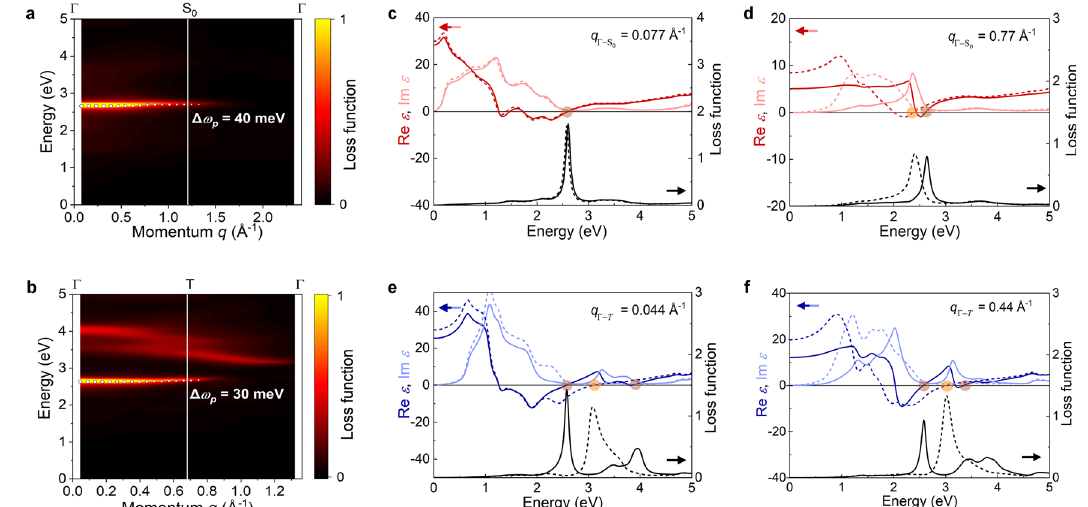
e , f Dielectric function (upper panel) and loss function (lower panel) of α -Ti 2 O 3 for q =0.044Å − 1 and q =0.44Å − 1 along the Γ - T direction, respectively. The data indi- cated by the solid (dashed) lines are results with (without) the LFE. The circles denote the zeros of Re ε ( q , ω ). Source data are provided as a Source Data fi